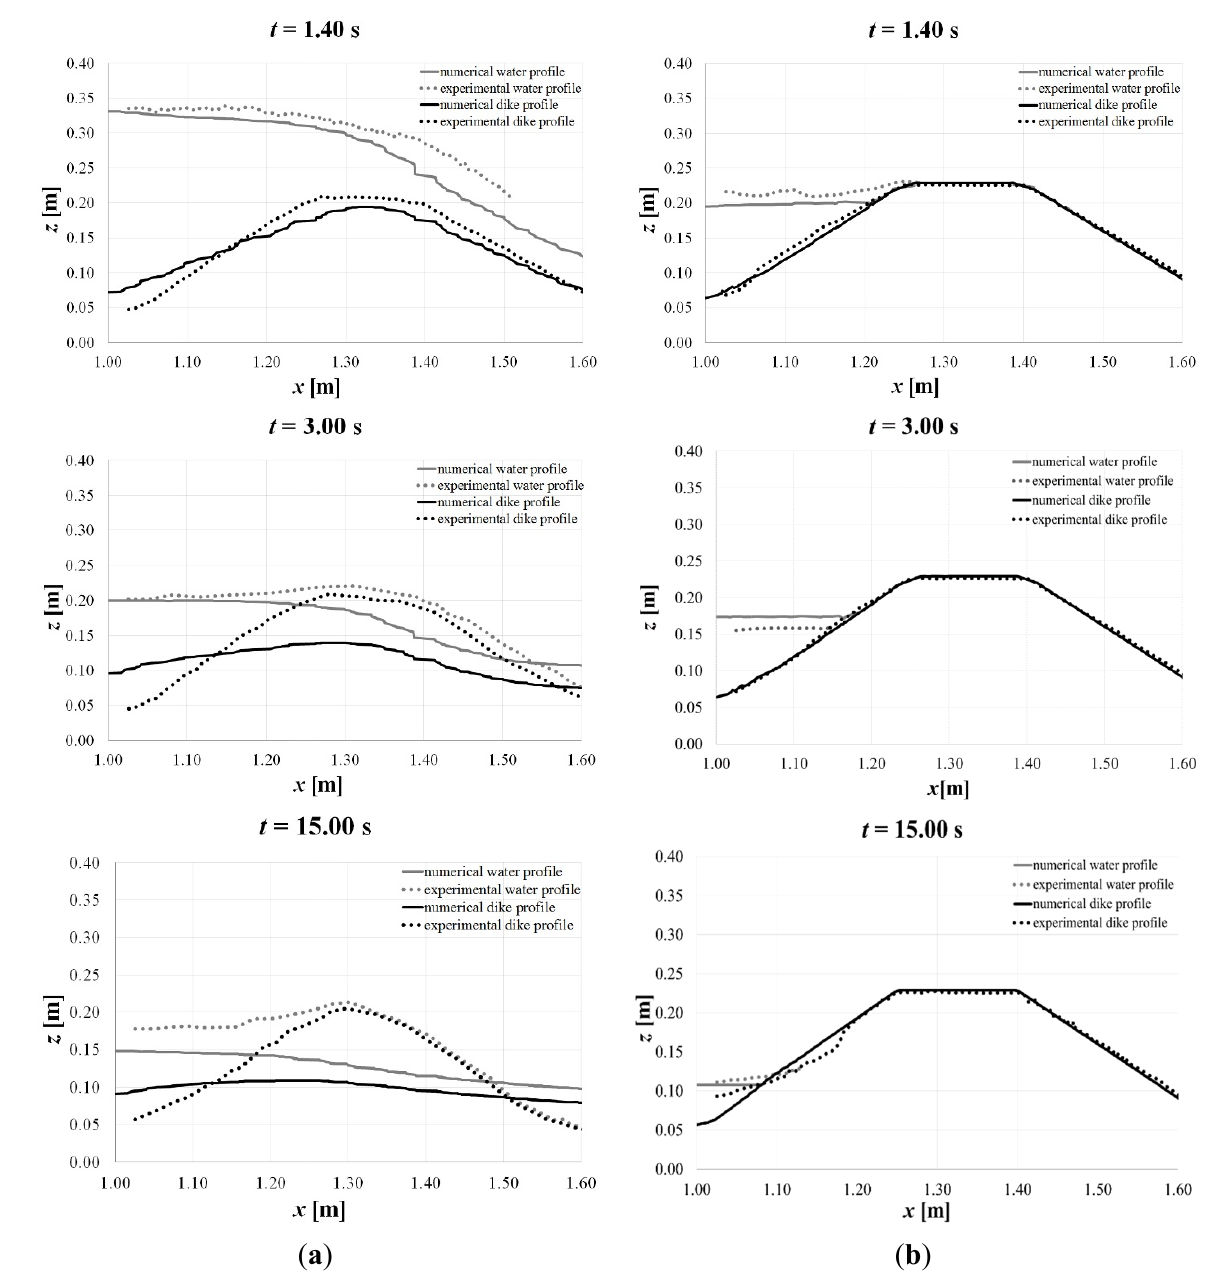
Figure 11. Comparison of the experimental results (dotted lines) against the numerical ones (solid lines) for Test A3 ( a ) and Test B1 ( b ): water (grey) and dike (black) profiles at times t = 1.40, 3.00 and 15.00 s,